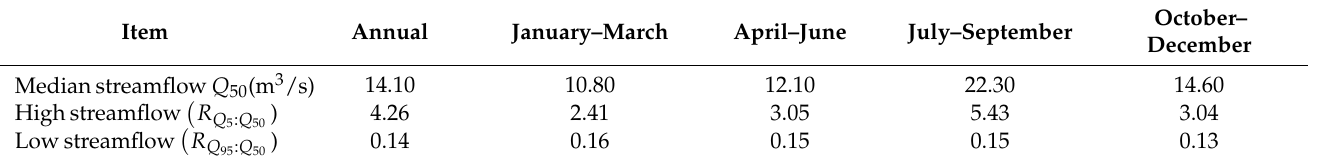
Table 3. Characteristics of daily FDCs of streamflow in the Beiluo River